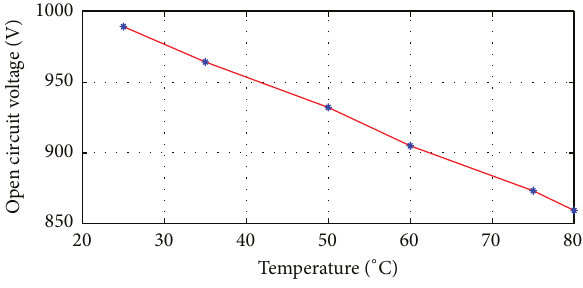
Figure 8: Variation of short circuit current according to the